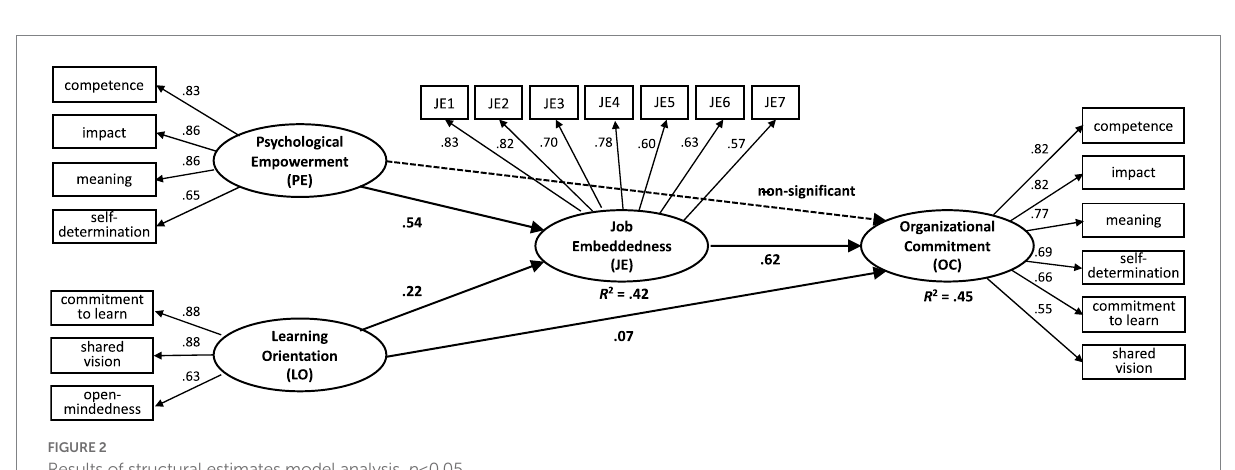
FIGURE 2 Results of structural estimates model analysis. p <